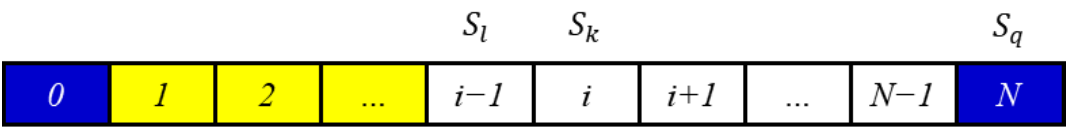
Figure 1. Event-sequence numbering in a one-dimensional Markov chain. In Equation (4), when the unit cell 𝑖 is separated away from unit cell 𝑁 , 𝑝 and 𝑝 𝑘𝑞(𝑁−𝑖) ineffective, because they are seemingly equivalent to a stationary probability.